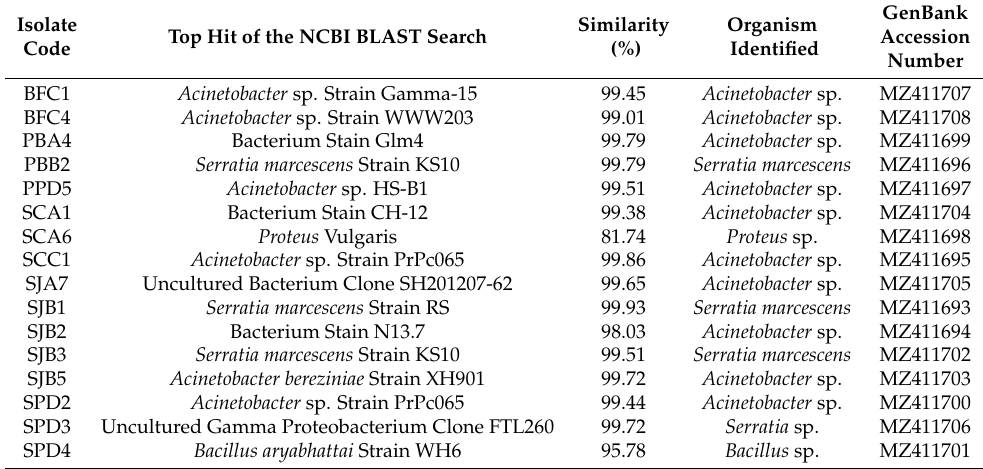
Table 4. Identity of PHA-producing bacteria based on 16S rDNA analysis. Isolate